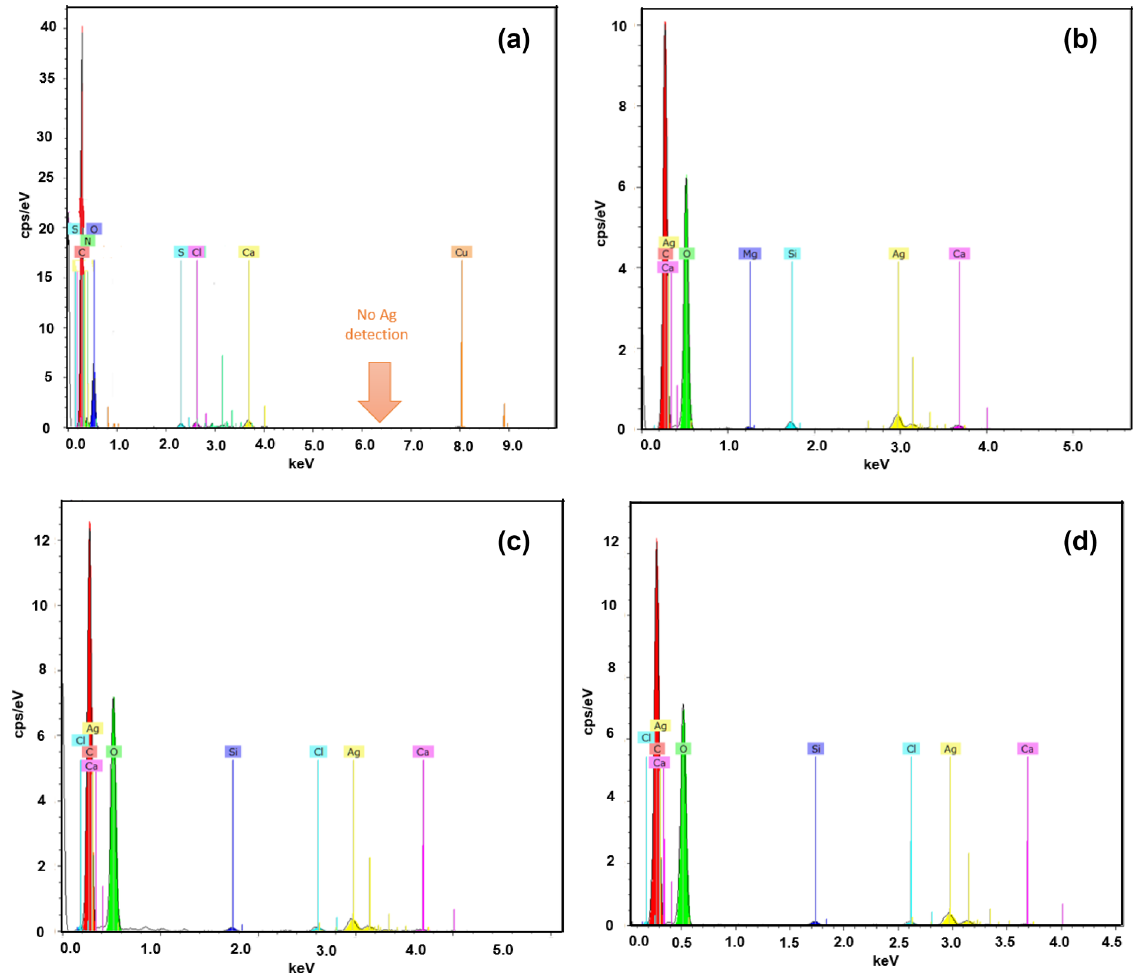
Figure 5. EDX spectra of the control and nanosilver treated sisal/cotton interwoven fabric specimens: ( a ) control sisal/cotton, ( b ) EAg1, ( c ) EAg2, and ( d ) EAg3.